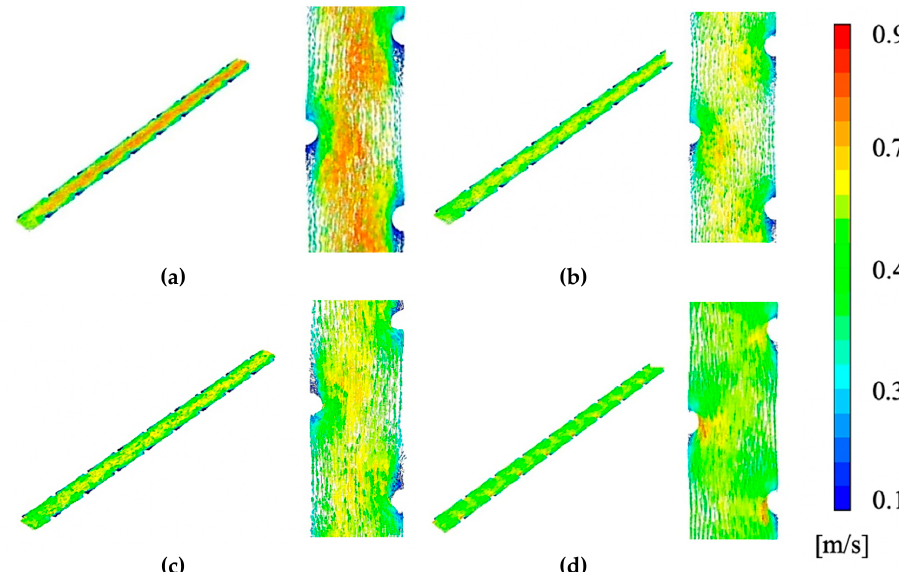
Figure 6. Assessment of velocity profiles with normalized inlet CFV of 0.575m/s, at ( a ) 0% occlusion, ( b ) 25%, ( c ) 50% and ( d ) 70% occlusion with